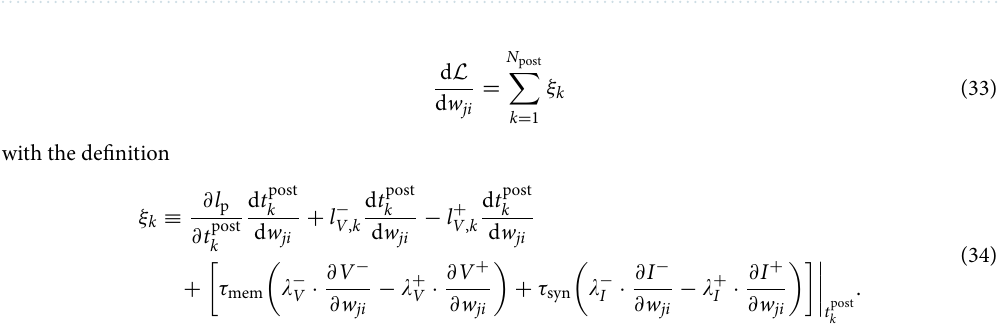
Figure 5. In this sketch, the relation v ( t , w ) − ϑ = 0 defines an implicit function (black line along which d v = 0 ). The critical point where the gradient diverges is shown in